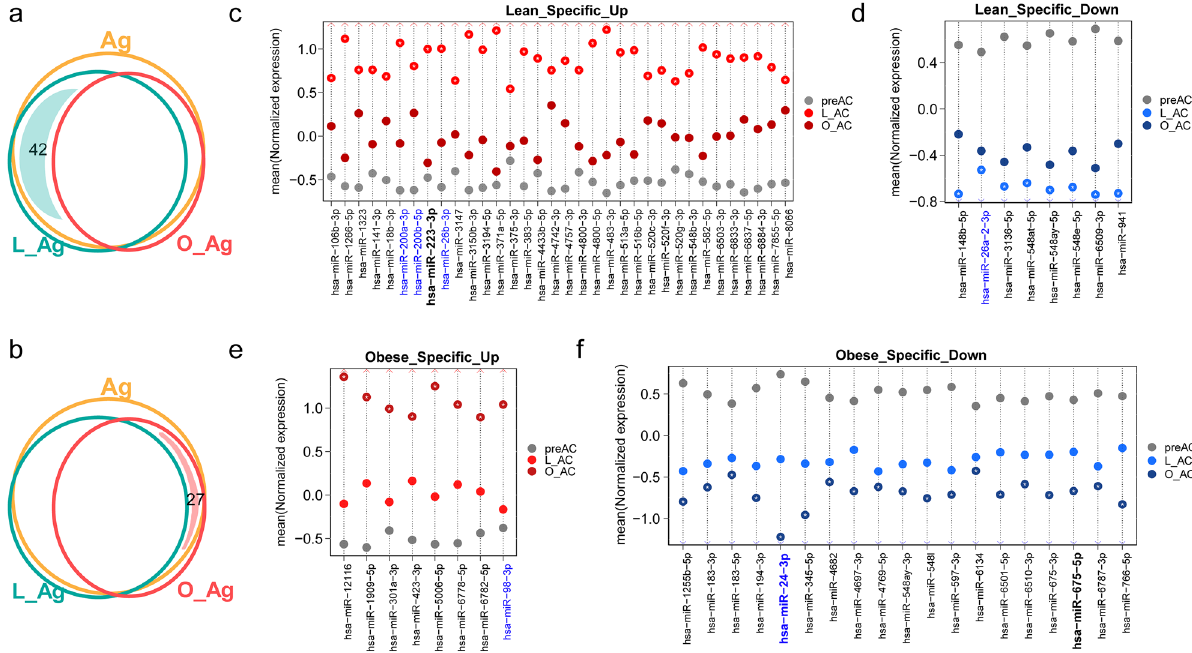
Figure 4. Analysis of DEMs identified only in the ‘Lean_Specific’ and ‘Obese_Specific’ categories. ( a ) Venn diagram depicting the number of DEMs obtained from the Lean_Specific category ( Q -value < 0.01 in L_Ag but Q -value ≥ 0.05 in O_Ag). Refer to the legend of Fig. 3a for the yellow, green, and red circles. The light-green shaded region represents the L_Ag area overlapping with Ag but not with O_Ag. ( b ) Venn diagram depicting the number of DEMs obtained from the Obese_Specific category ( Q -value < 0.01 in O_Ag but Q -value ≥ 0.05 in L_Ag). Note that the same meanings for the yellow, green, and red circles are the same as in ( a ). The light- red shaded region represents the O_Ag area overlapping with Ag but not with L_Ag. ( c , d ). The mean values (Y-axis) of miRNA expression are plotted for each cell type group. The miRNAs known to be associated with adipogenesis are colored blue, those associated with the inflammatory response are highlighted in bold, and those related to adipogenesis and the inflammatory response are colored blue and highlighted in bold. ( e , f ) Same as ( c , d ) but for DEMs obtained from the Obese_Specific